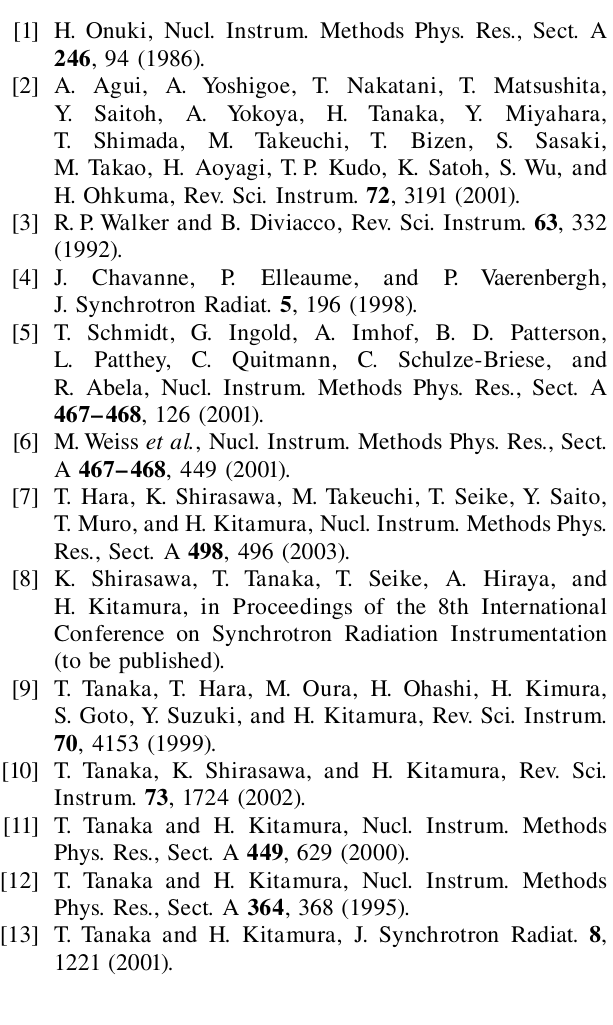
of the 2nd harmonic 3